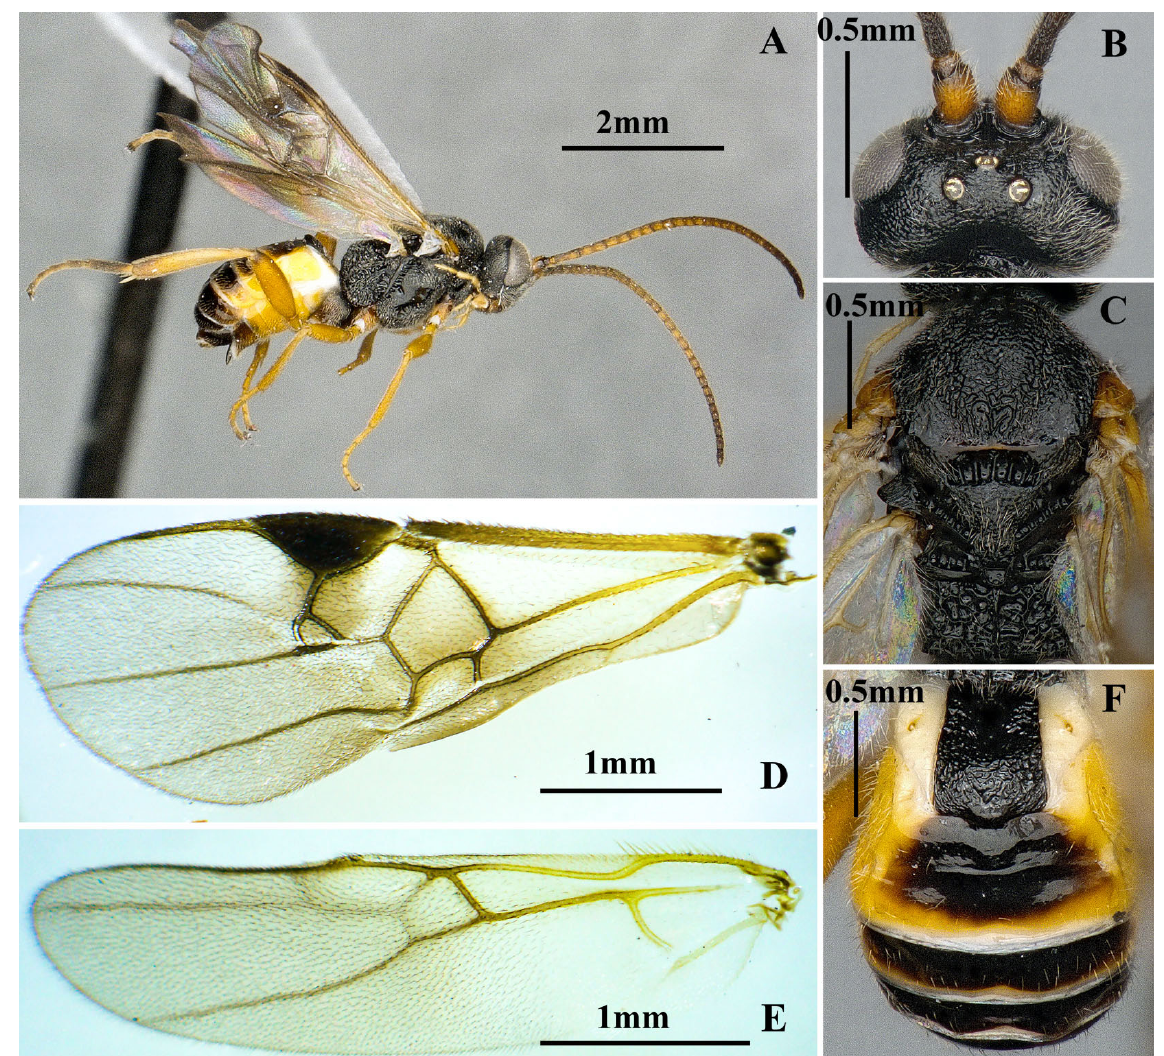
Fig. 5. Microplitis eremitus Reinhard, 1880, ♀, TMUC-HBMMP0017. A . Habitus, lateral view. B . Head, dorsal view. C . Mesosoma, dorsal view. D . Fore wing. E . Hind wing. F . Metasoma, dorsal